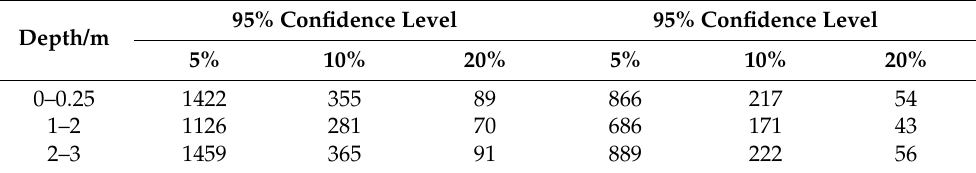
Table 2. Statistics of sampling number of soil salt content.